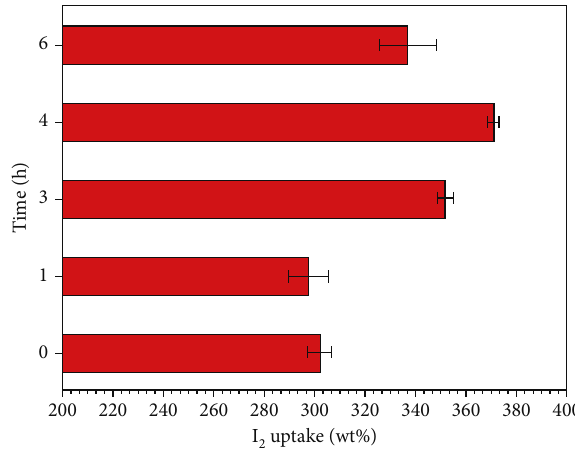
Figure 6: Saturation adsorption capacity of MIL-101 with di ff erent etching times for gaseous